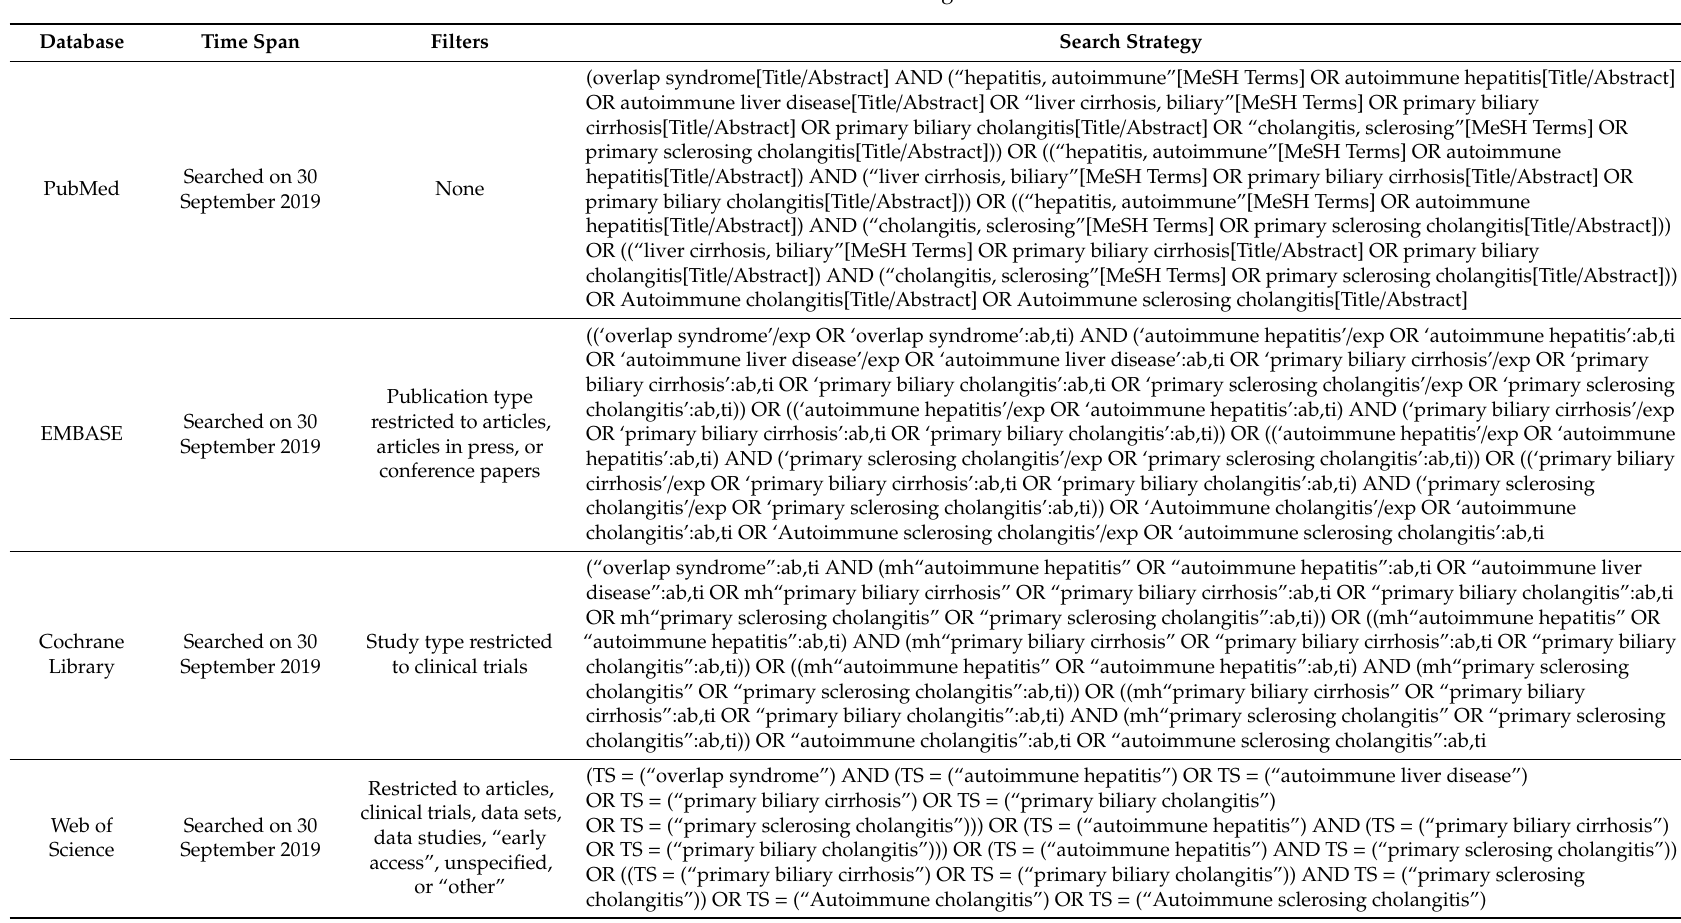
Table A1. Search